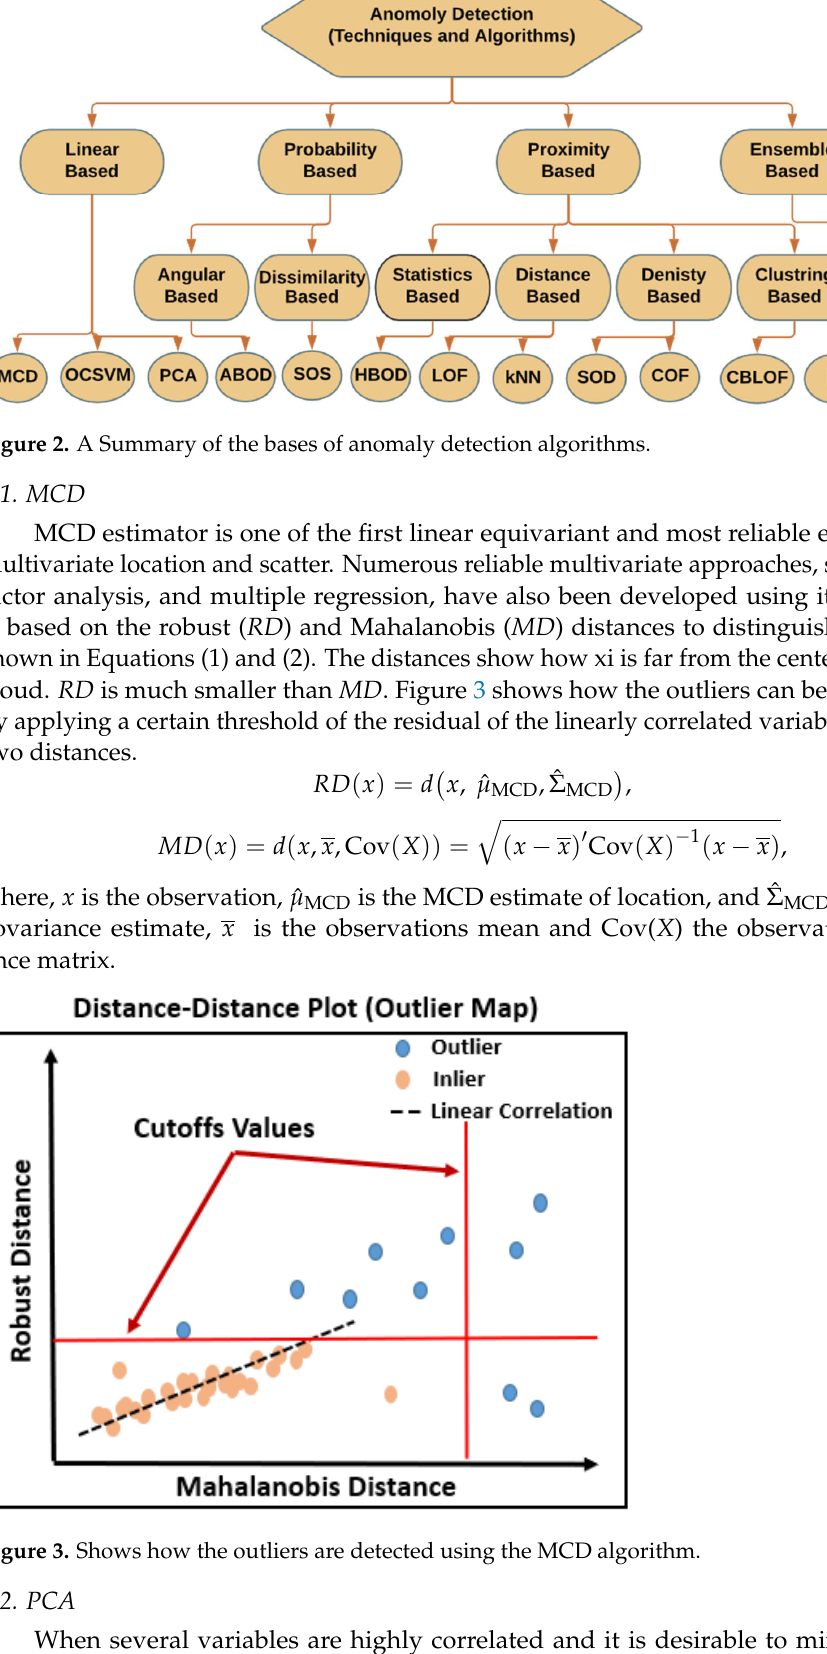
Figure 2. A Summary of the bases of anomaly detection